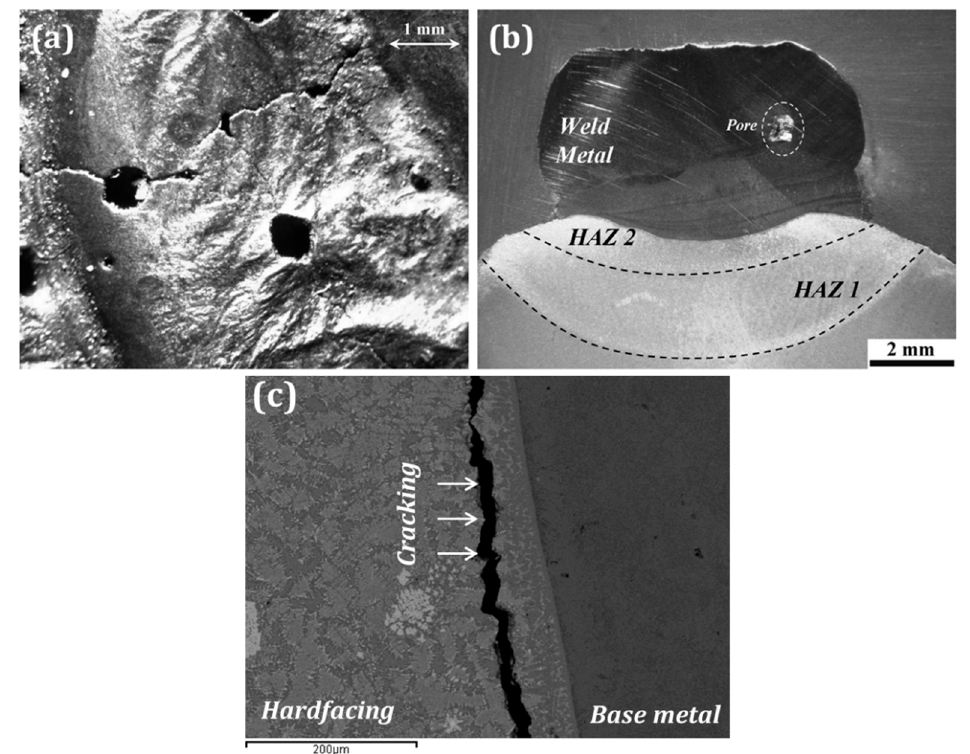
Figure 11. Microstructure flaws in hardfacing overlayers deposited manually via arc welding technique: ( a ) stereoscopic image of top view, revealing the development of surface pores and cracks; ( b ) optical image of a cross-section, revealing the existence of a sub-surface isolated macro-pore; and ( c ) SEM image of a cross-section at the vicinity of the base metal, indicating the development within the overlayer of a crack parallel to the interface.